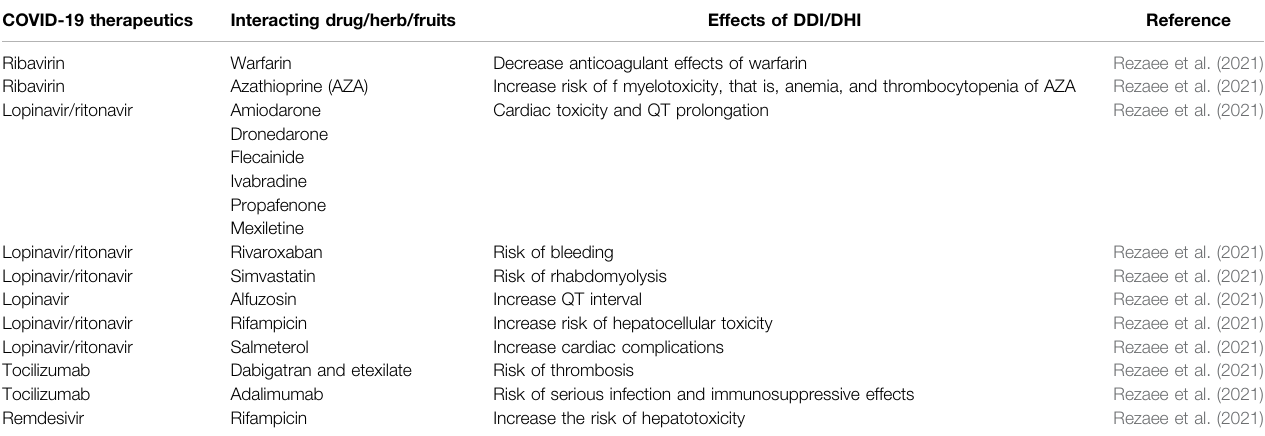
TABLE 8 | Potential clinically signi fi cant DDIs of COVID-19 therapeutics. COVID-19